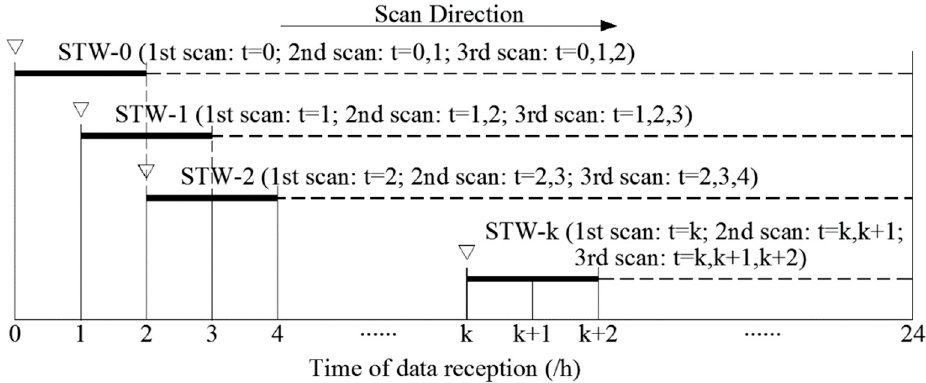
Figure 2. Schematic diagram of real-time leak detection scanning when STWL = 3.